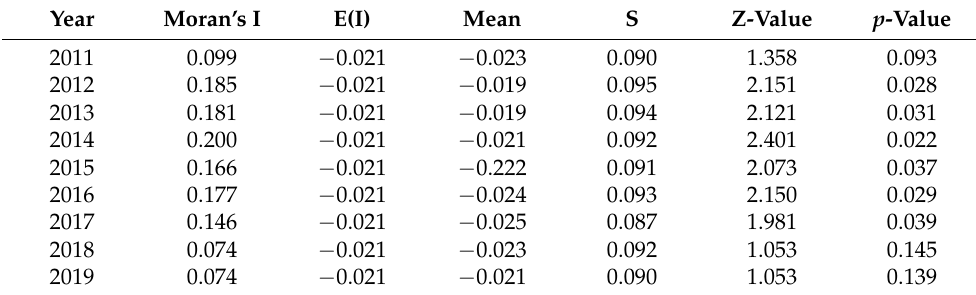
Table 1. Global spatial autocorrelation